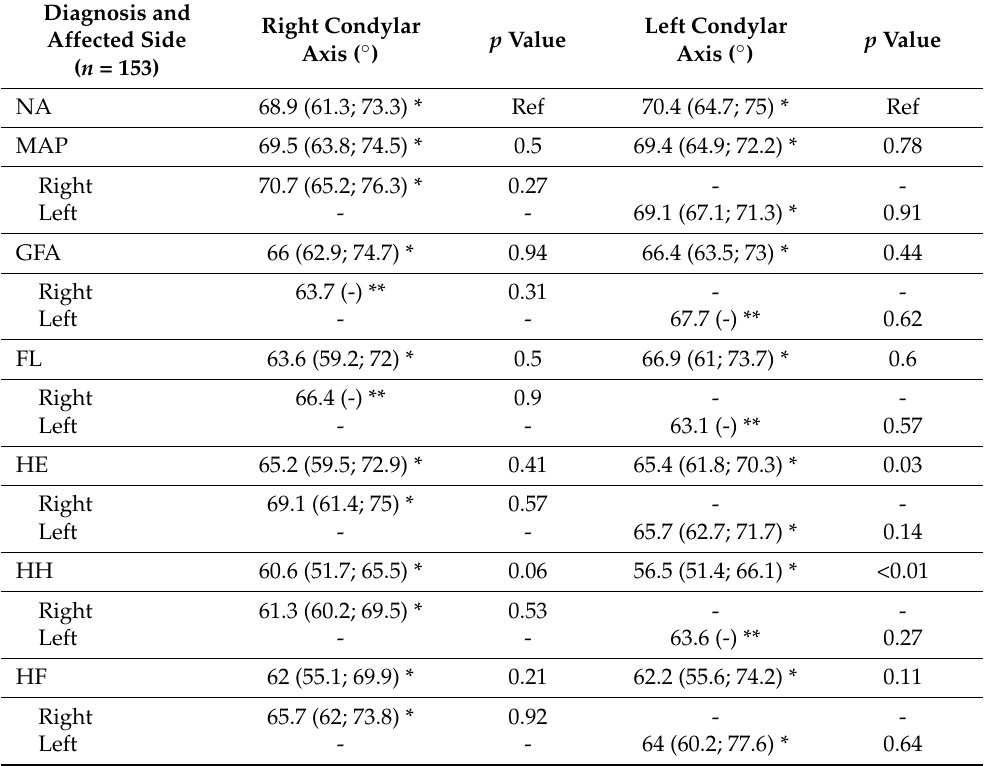
Table 6. Comparison of condylar axis angle data by sides in without FA group vs. FA groups.